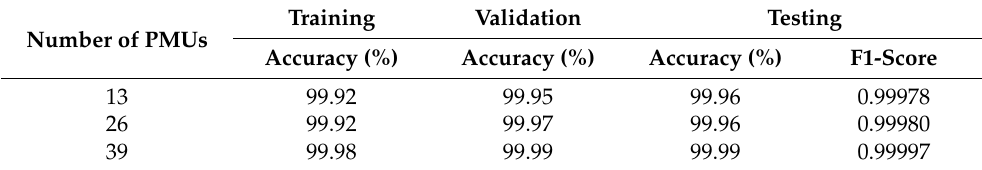
Table 9. Recapitulation of test results for the effect of the number of